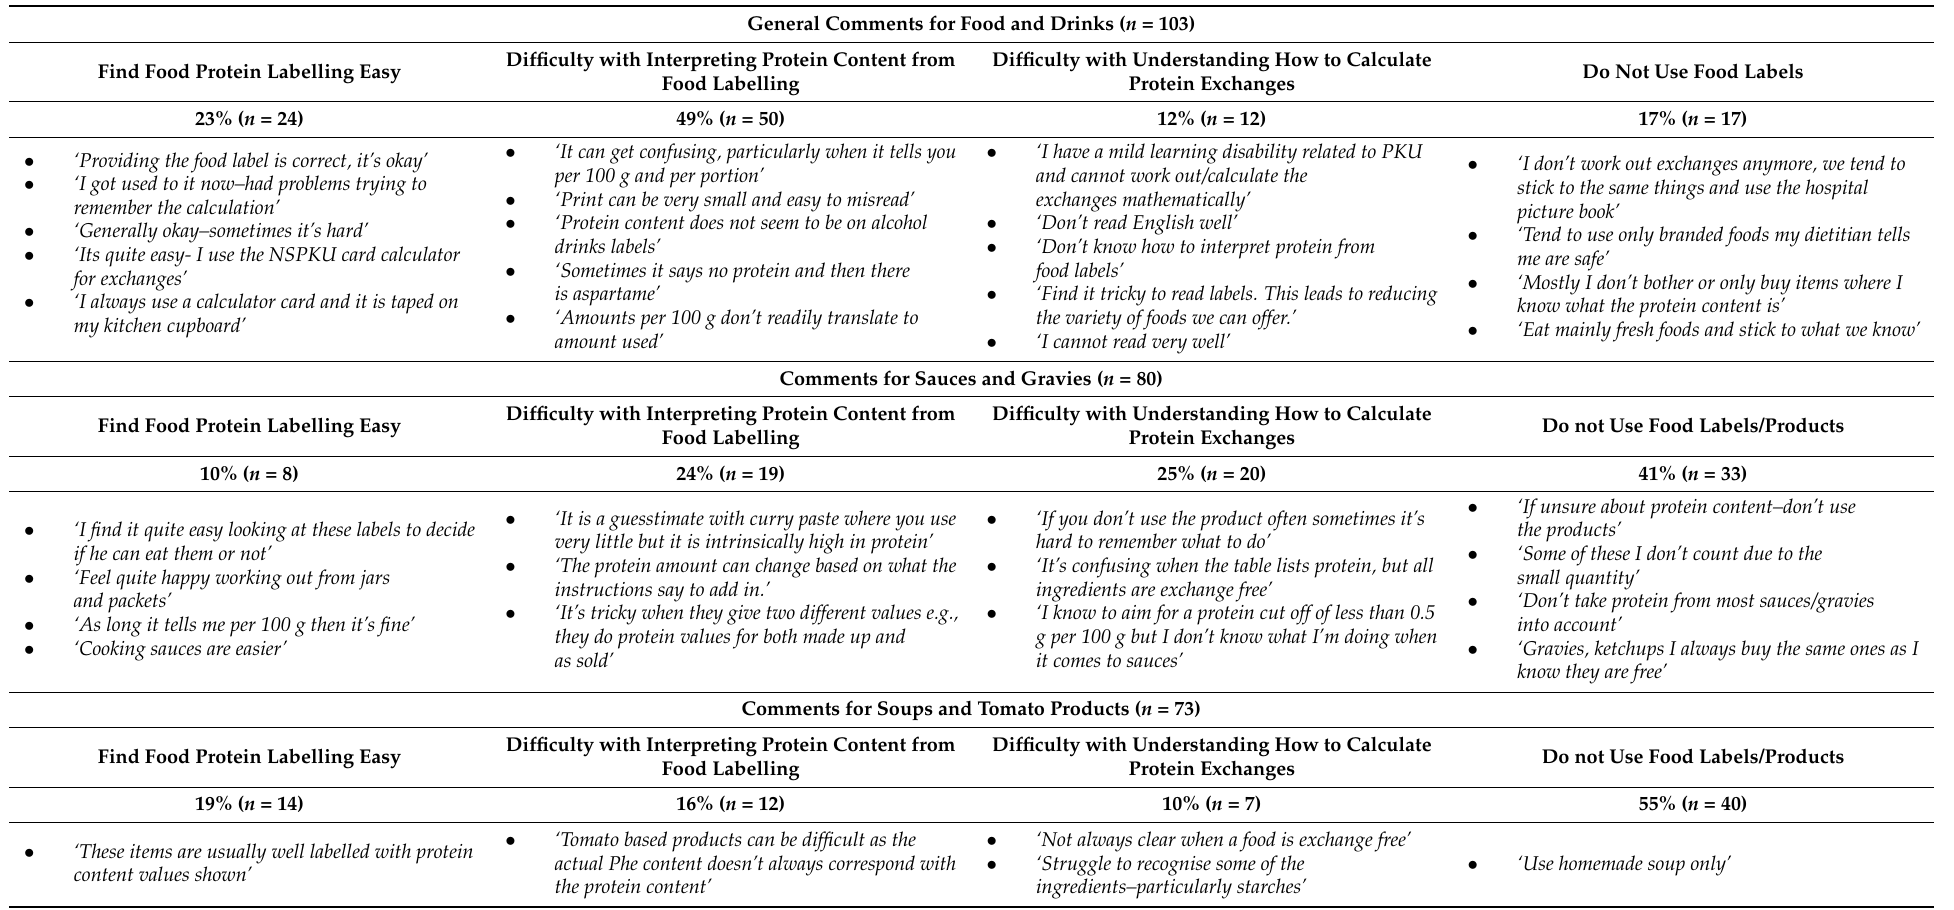
Table 2. Verbatim comments about ease of calculating protein exchanges from protein content on manufactured food